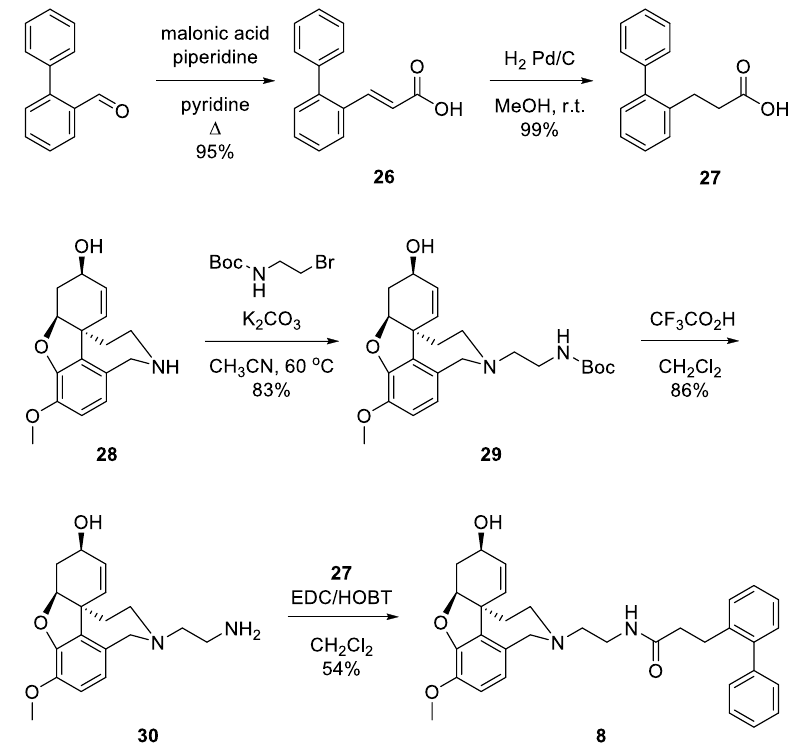
Table 2. Physicochemical properties, neurotoxicity and anti-AChE activity of compound 8 .